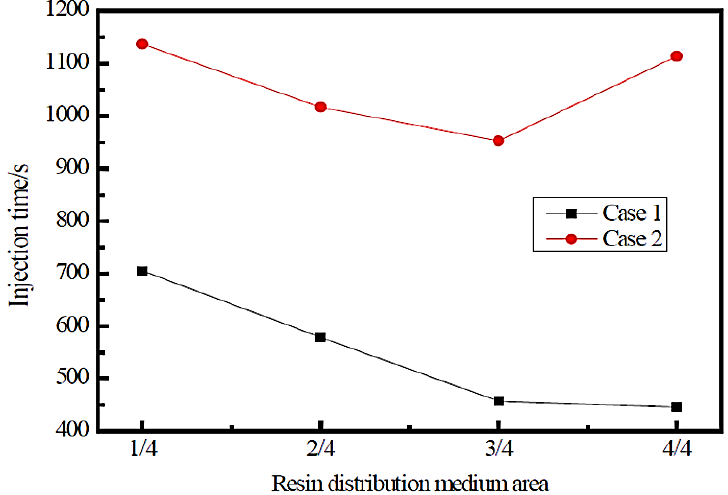
Figure 6. Resin flow time under different injection schemes [74]. Reproduced with permission from MDPI.